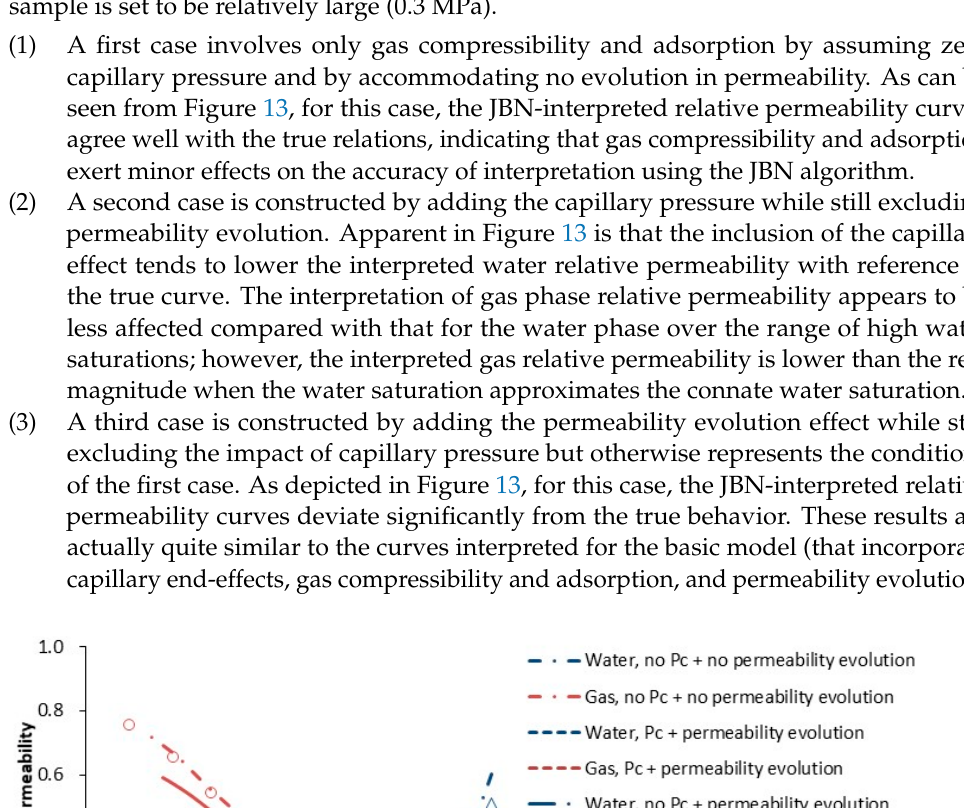
Figure 12. Comparison of the Johnson – Bossler – Naumann (JBN) interpreted versus true relative permeability curves.